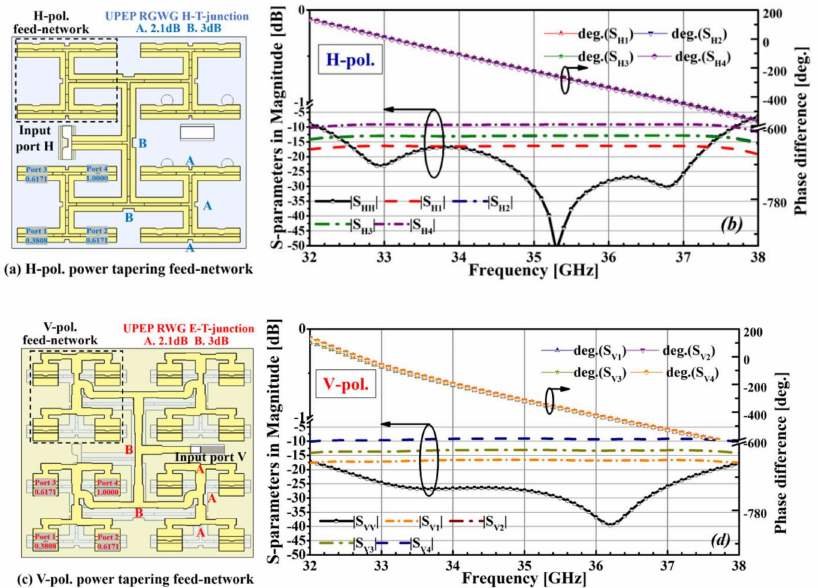
Figure 9. Configuration and simulated performance of the power-tapering feed networks: